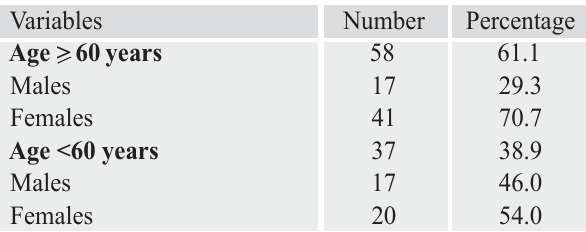
Table II: Sex distribution of hypokalemic patients according to age groups (n=95)